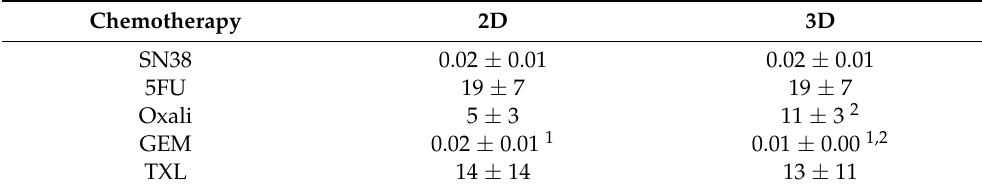
Table 3. The 72 h cytotoxicity of chemotherapeutic agents in MiaPaCa2 cells, reported as IC 50 values ( µ